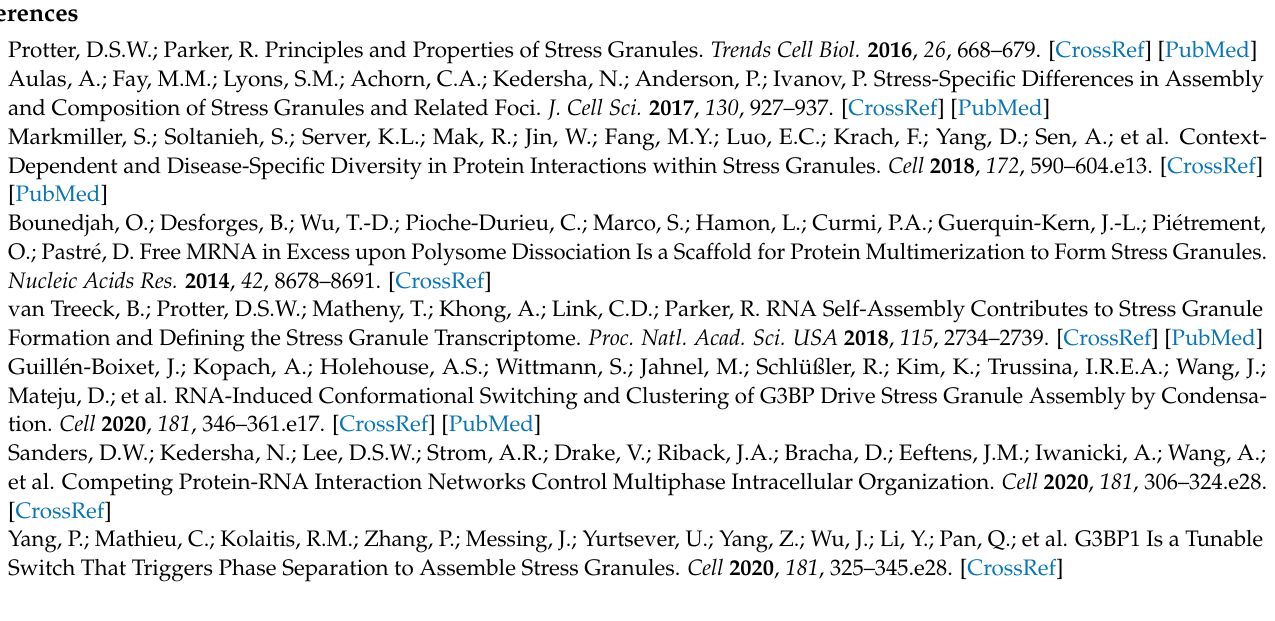
eIF2A; Figure S2. PARP1 activity contributes to stress assembly; Figure S3. PARP1 activity contributes to stress assembly if the polysomes were previously destabilized; Figure S4. PAR enrichment was not observed in SG formed in the H2O2- and arsenite-induced stress conditions; Figure S5. Western blot analysis of PARG expression; Figure S6. PARP1 activation may prevent the shuttling of HuR to the cytoplasm; Figure S7. Analysis of stress granule composition and assembly; Table S1 and